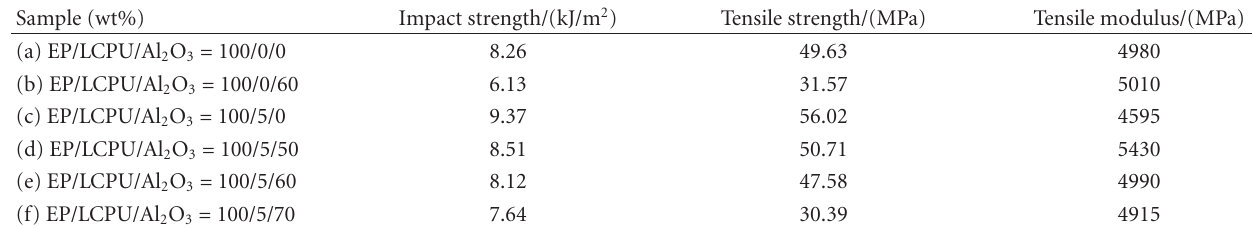
Figure 2: SEM micrographs of fractured surface of the composites: (a) pure epoxy; (b) EP/LCPU = 100/5; (c) EP/LCPU/Al 2 O 3 = 100/5/50; (d) EP/LCPU/Al 2 O 3 = 100/5/70. Table 1: Influence of Al 2 O 3 contents on mechanical properties for the epoxy resin systems.